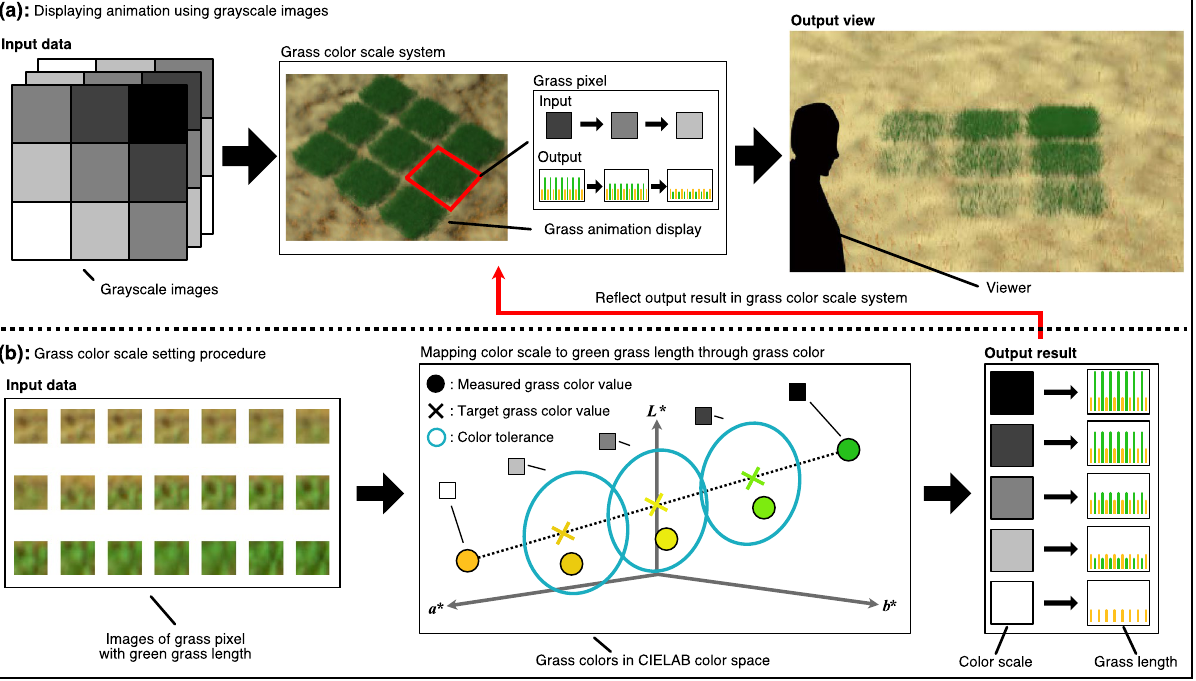
Figure 2. Concept of displaying grass color corresponding to color scale. ( a ) A grass color scale system allows a grass animation display to show an animation using grayscale images. The color scale corresponds to a green grass length. ( b ) Green grass length of the grass pixel corresponding to the color scale is determined using a grass color scale setting procedure. The results are reflected in the grass color scale system to show the animation on the grass animation display. This figure was created using Autodesk 3ds Max version 2021 (https:// www. autod esk. com/ produ cts/ 3ds- max/ featu res) and Serif Affinity Designer version 1.10.0 (https:// affin ity. serif. com/ en- length. The grass colors based on the green grass length corresponding to the color scale must be evenly sepa- rated to ensure clear animations. We develop a grass color scale setting procedure to map the grass length to the color scale through image processing, as shown in Fig. 2b. The grass color scale setting procedure provides the green grass length for each level of the color scale using the grass colors of the grass pixel measured by a digital camera at regular green grass length intervals. In the setting procedure, the CIE 1976 L ∗ a ∗ b ∗ (CIELAB) color space and the color difference formula of CIEDE2000 are adopted to evaluate the grass color. To avoid an effect of a unique camera maker’s image processing engine, the grass color is captured as a raw image and measured in the CIELAB color space through the sRGB color space. The measured value is referred to as a measured grass color value. The measured grass colors suitable for the color scale are obtained by comparing the measured grass color values with target grass color values, which are CIELAB values of reference grass colors corresponding to the color scale. The target grass color values corresponding to minimum and maximum levels of the color scale are the measured grass color values when the green grass lengths are minimum and maximum, respectively. Then, other target color values are calculated as CIELAB values that equally divide the color difference of the CIEDE2000 between the target grass color values corresponding to the minimum and maximum levels of the color scale. Further, each target grass color value has a color tolerance. When each color tolerance includes the measured grass color value closest to each target grass color value, the measured grass pixel is considered to be capable of displaying the grass colors corresponding to the color scale. Therefore, the color scale can be mapped to the green grass length using the measured grass colors corresponding to the color scale. Then, the grass ani- mation display can show the animation clearly by reflecting the results of the grass color scale setting procedure in the grass color scale system. To achieve a simple grass color scale for the grass animation display, we focus on the grass pixel that show the grass color corresponding to a color scale of five levels with reference to the color scale of retro games. We conducted experiments with the grass color scale setting procedure in natural sunlight from 10:00 a.m. to 2:00 p.m., developing a grass pixel for our outdoor experiments. The green grass length was changed from 0.00 to 15.00 [mm], and the grass color of the grass pixel was measured at regular intervals of 0.75 [mm]. Moreover, the experiments were conducted at multiple camera positions focusing on a viewer’s height, a distance, and a horizontal angle between the viewer and the grass pixel. Through the experiments, the grass pixel possibilities of the color scale are clarified, such that the color scale corresponds to the green grass length for each camera position. In addition, we conducted experiments focusing on the repeatability and reliability of the grass pixel. In the experiments, we revealed that the grass pixel could show the same grass color to several camera positions when the same grass length was repeatedly inputted in natural sunlight from 10:00 a.m. to 2:00 p.m. After the